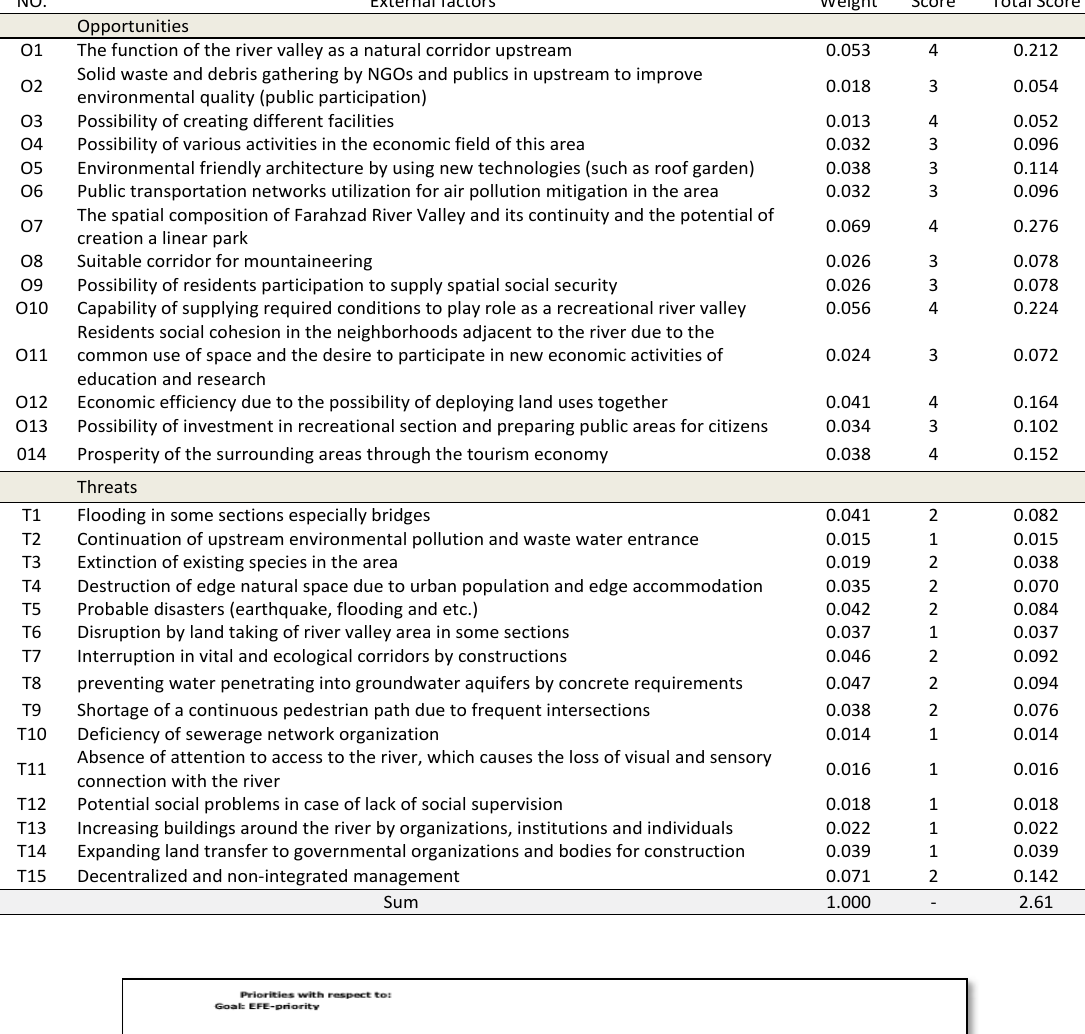
Table 3: EFE of Farahzad River Valley area